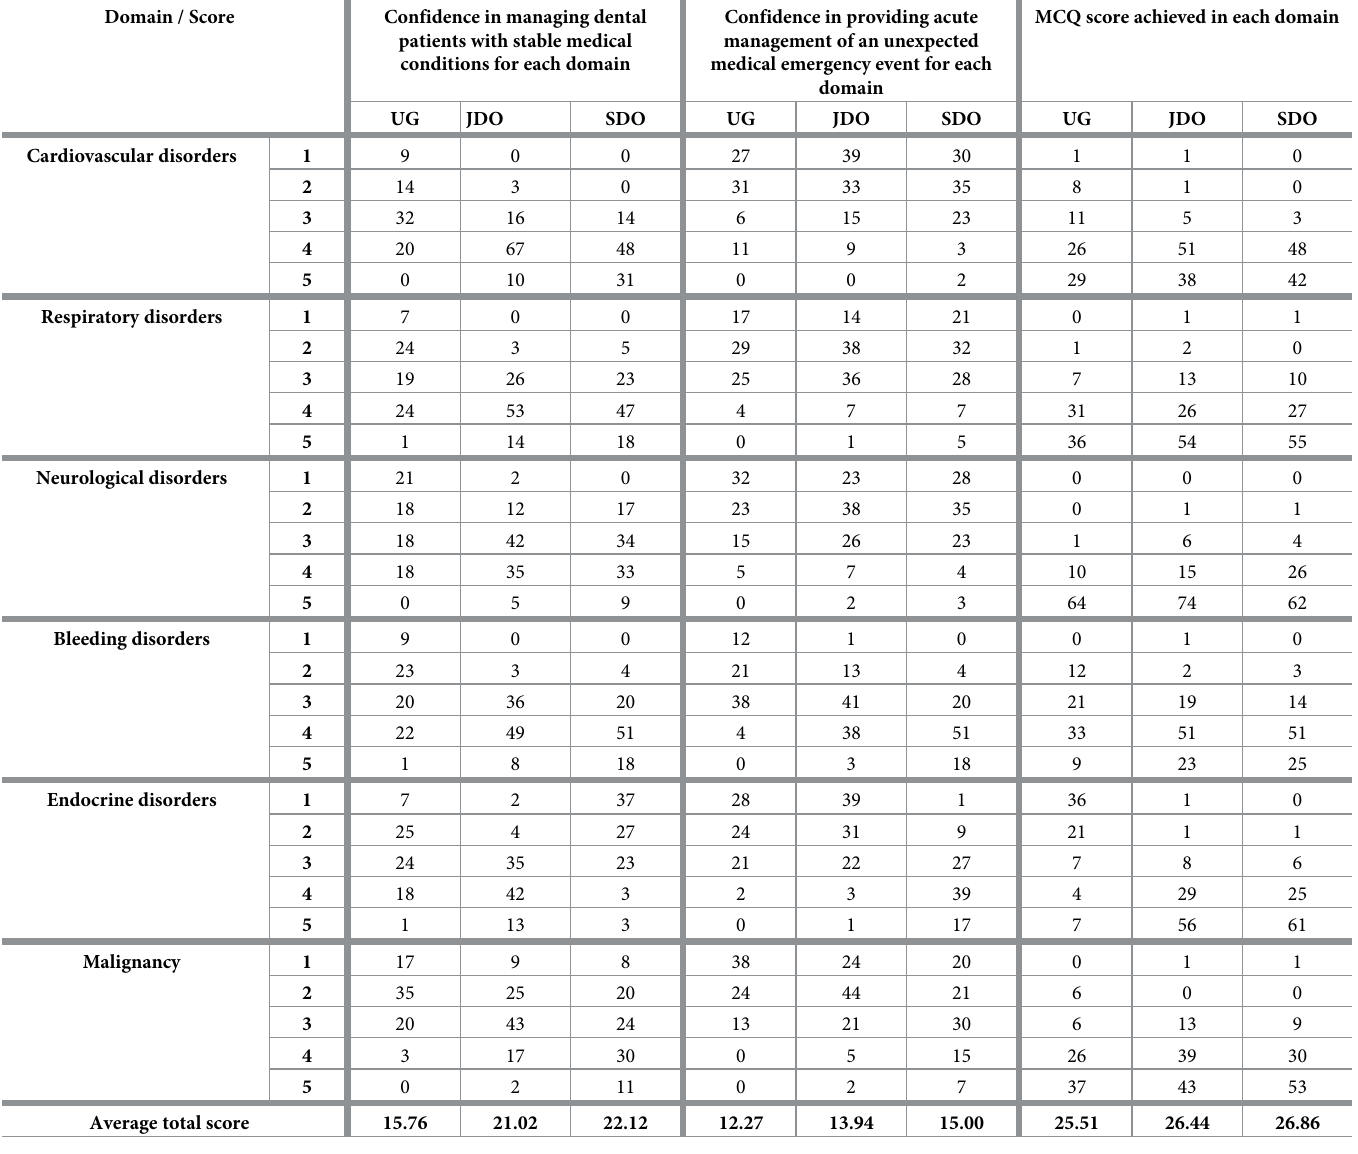
Table 4. Self-rated perceived confidence and MCQ